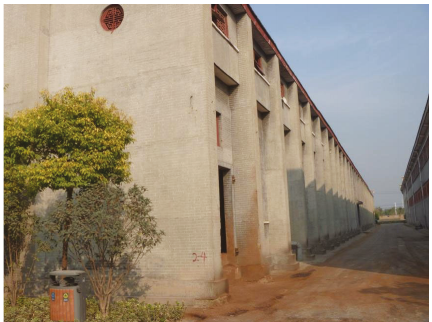
Figure 14: Surface buildings after back fi lling mining in the Yangzhuang Coal